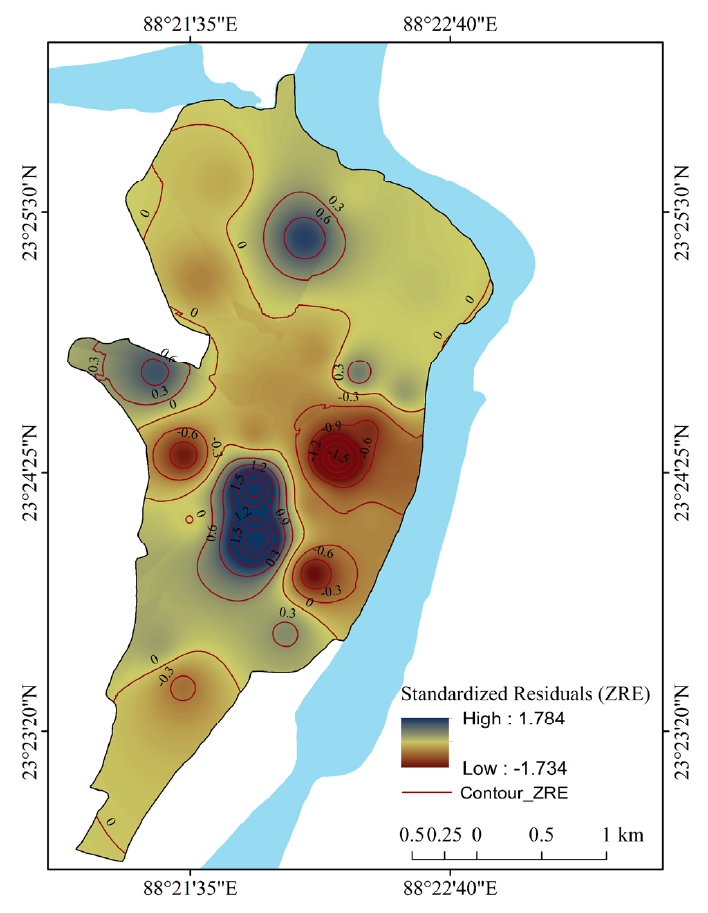
Figure 53. Plots of regression ZRE (2015).